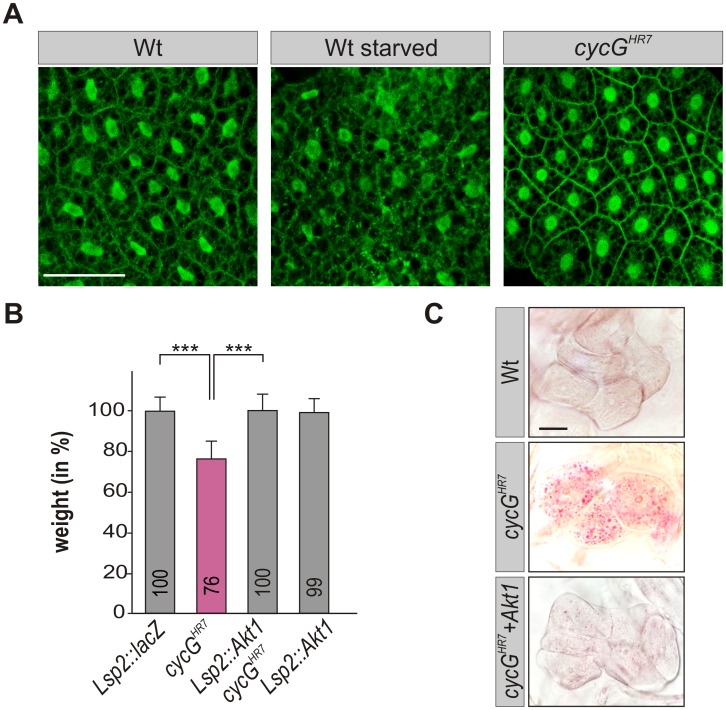

CycG acts genetically downstream of PI3K92E.(A) tGPH localization in fat body cells of either well-fed or starved wild type (tGPH/CyO; WT, left panels) or of well-fed cycG
HR7mutant larvae (tGPH/CyO; cycG
HR7
/cycG
HR7; right panel) is shown. Membrane localization of tGPH, an indicator of PI3K92E activity, was not apparently altered in cycG
HR7 mutant larvae compared to well-fed wild type. Scale bar: 100 μm. (B) Overexpression of Akt1 specifically in the larval fat body using the Lsp2-Gal4 driver rescues the reduced body weight of homozygous cycG
HR7 mutants. Genotypes are: Lsp2-Gal4/UAS-lacZ. cycG
HR7
/cycG
HR7. UAS-Akt1/+, Lsp2-Gal4 cycG
HR7
/cycG
HR7. UAS-Akt1/+, Lsp2-Gal4/+. Error bars denote standard deviation [n = 100 per genotype]. ***p<0.001 according to Student’s T-test. (C) Lipid droplet accumulation in the oenocytes of the cycG
HR7 mutant is largely normalized by the overexpression of Akt1 within the larval fat body. Genotypes are: wild type (upper panel); homozygous cycG
HR7 (middle); UAS-Akt1/+, Lsp2-Gal4 cycG
HR7
/ cycG
HR7 (lower panel). Scale bar: 20 μm. For a statistical evaluation see S3 Fig.